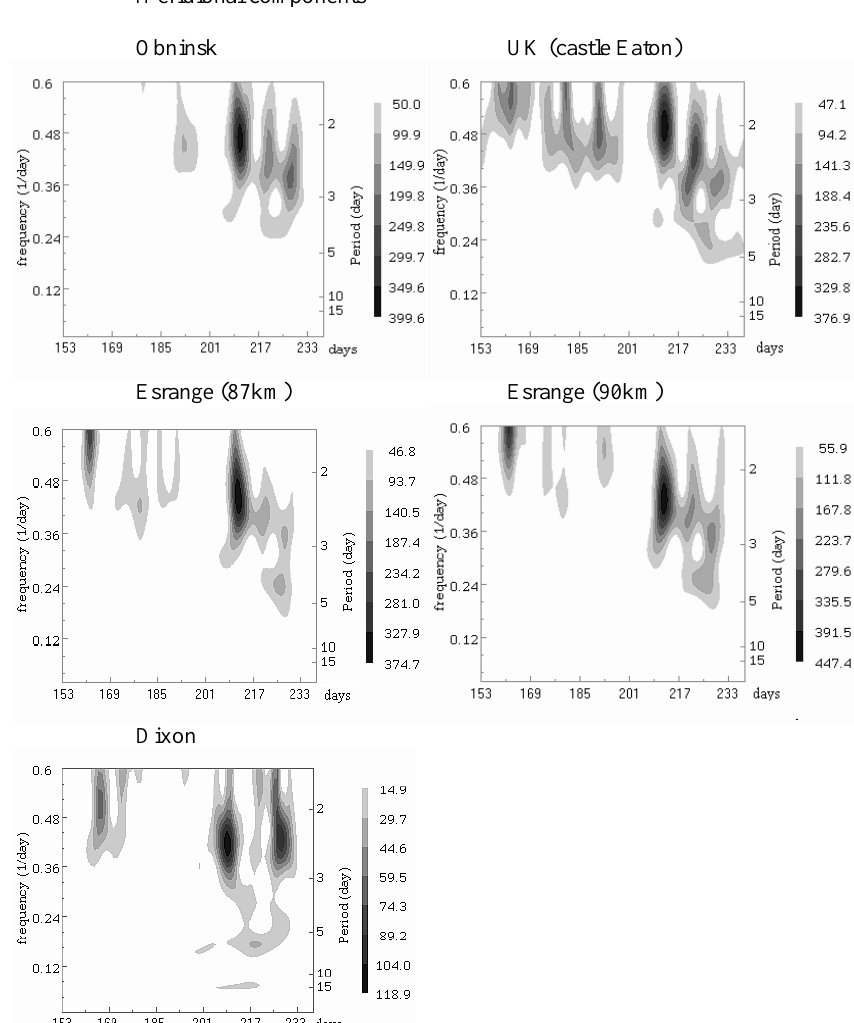
Fig. 3. As for Fig. 2, but for the meridional wind